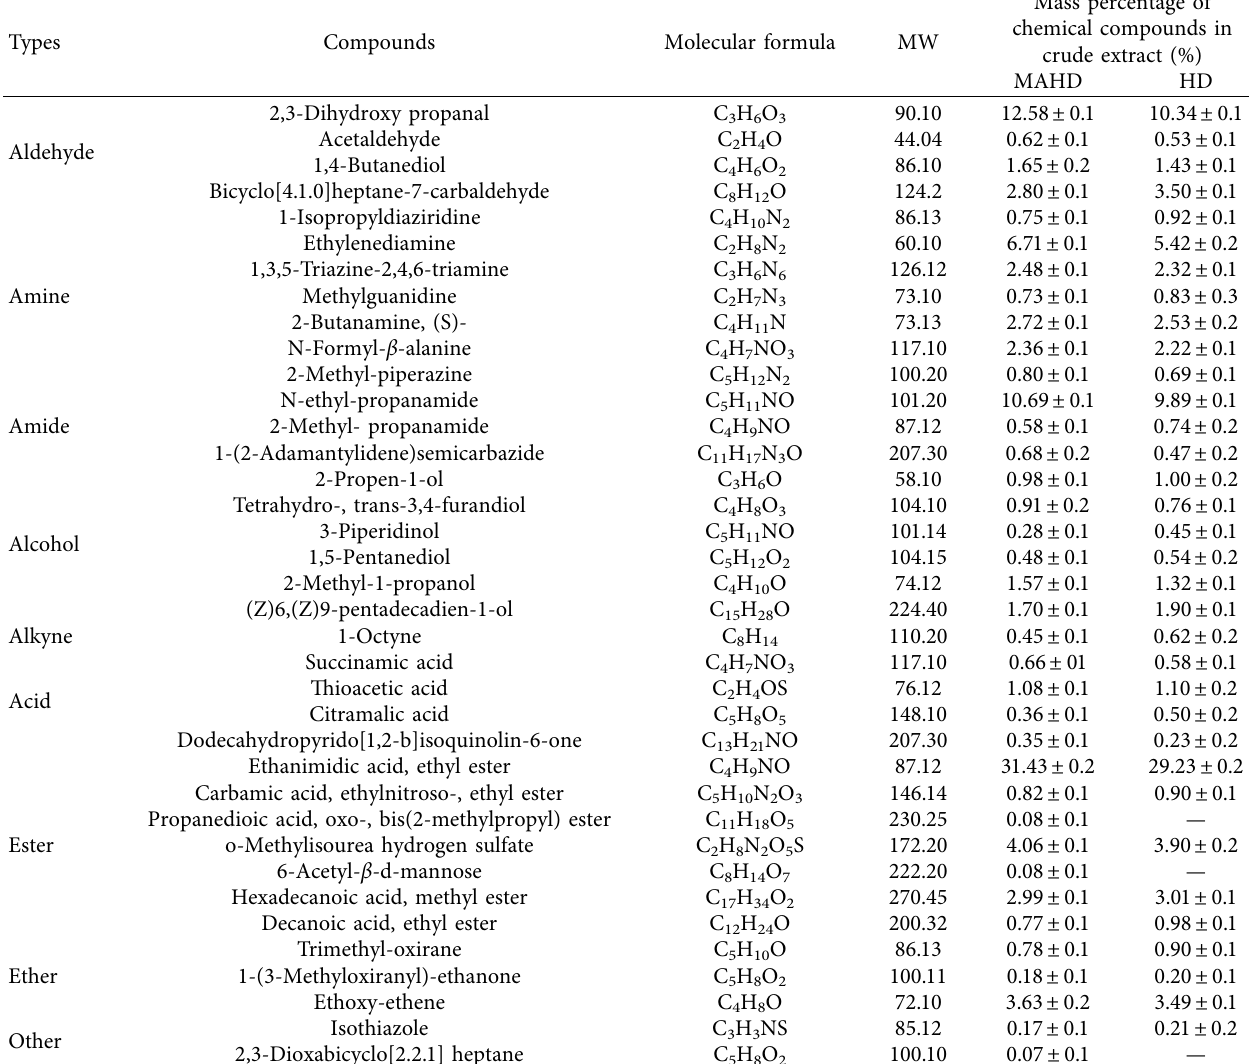
Table 2: The average chemical composition of compounds in hibiscus flower